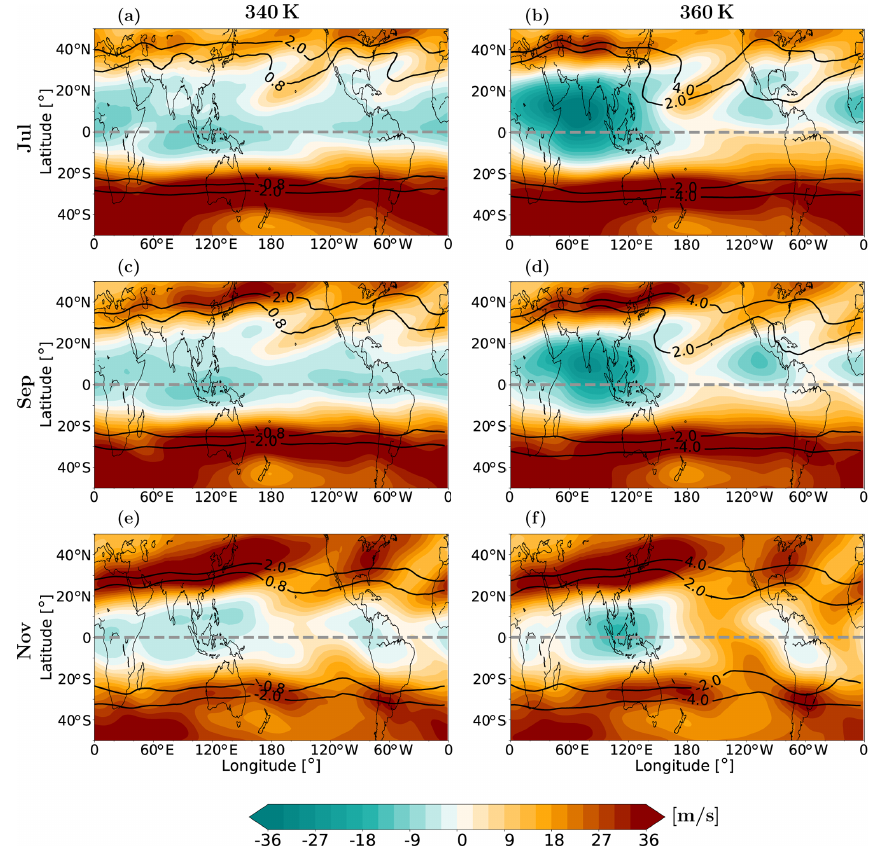
Figure 9. Climatological (1999–2017) horizontal distribution of zonal wind on the 340 and 360K isentropic surface during July, September, and November. The potential vorticity is indicated by the black